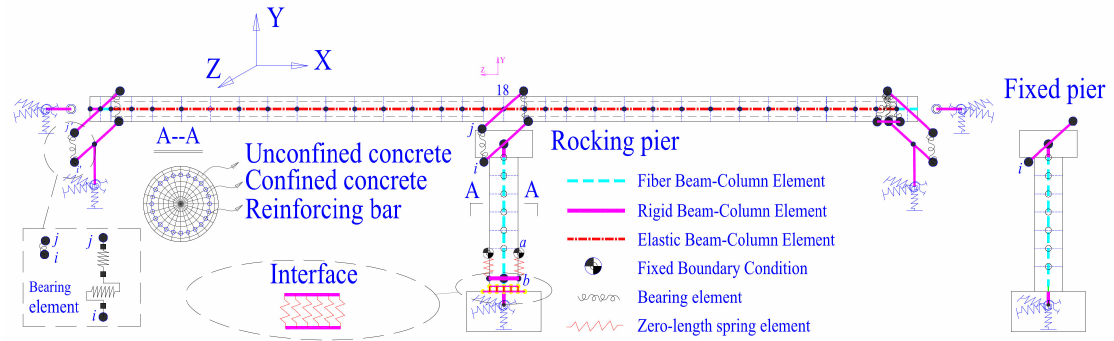
Figure 7. Schematic illustration of the FE bridge model and modeling